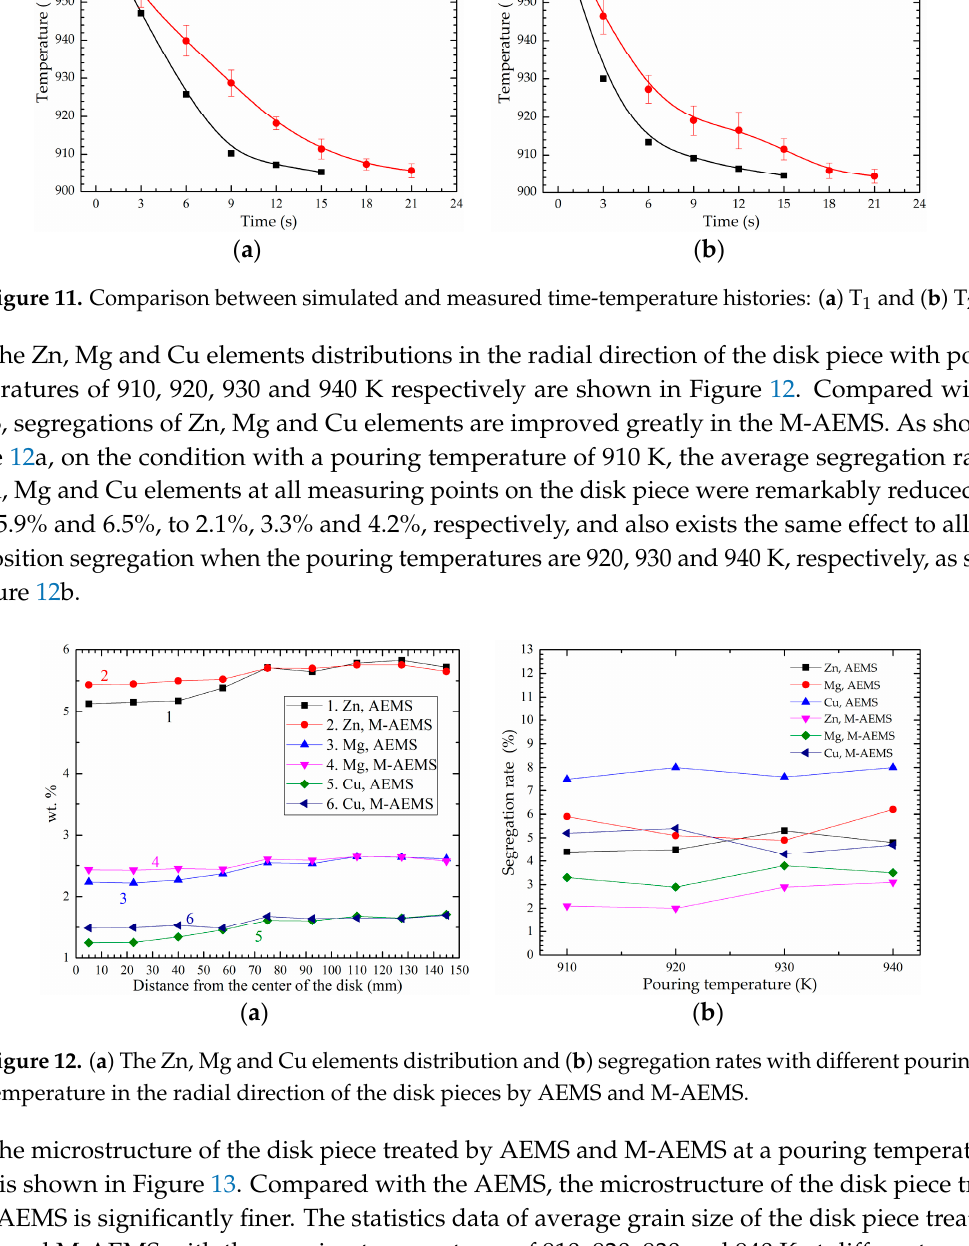
( f ) Figure 13. The microstructure of the disk pieces treated by AEMS and M-AEMS with the pouring temperature of 910 K at different sampling locations: ( a ) M 1 , AEMS; ( b ) M 2 , AEMS; ( c ) M 3 , AEMS; ( d ) M 1 , M-AEMS; ( e ) M 2 , M-AEMS; ( f ) M 3 , M-AEMS.